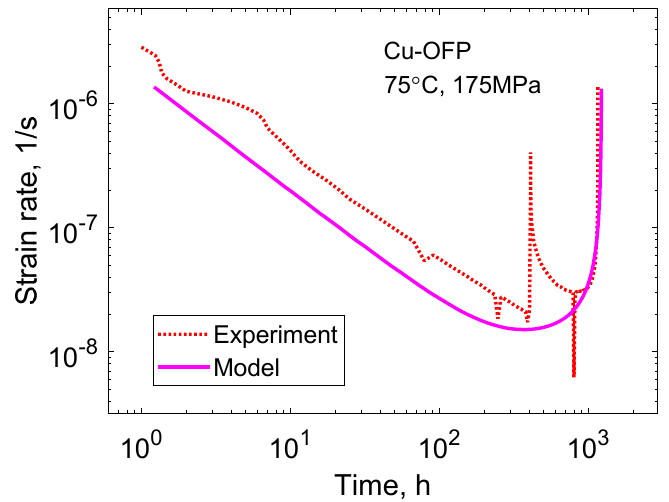
Figure 15. Creep rate versus time for the curve in Figure 13 (Cu-OFP, 75 °C, and 175 MPa). Forged material. Redrawn with permission from ref. [17]. Copyright 2022 Elsevier.